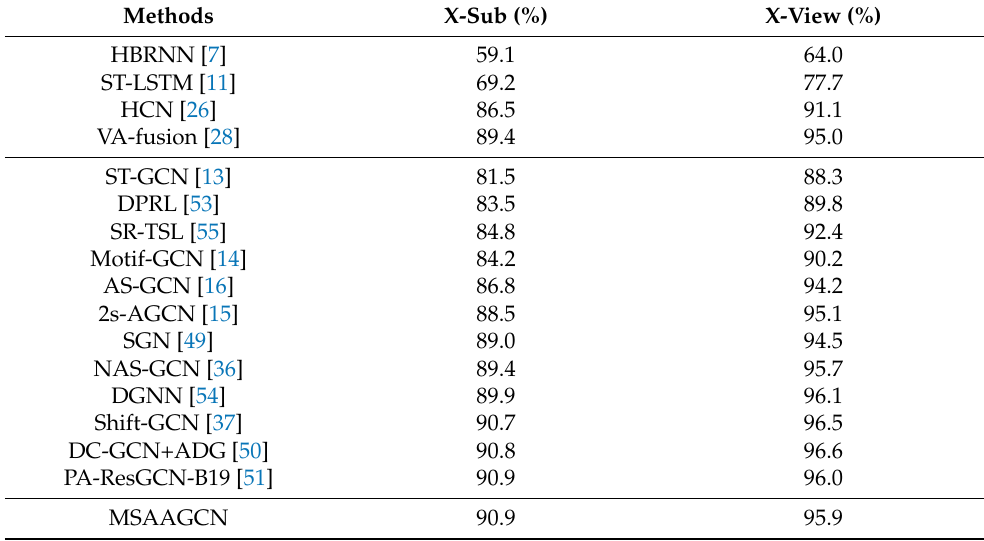
Table 5. Comparisons of the Top-1 recognition accuracy with the state-of-the-art methods on the NTU RGB+D